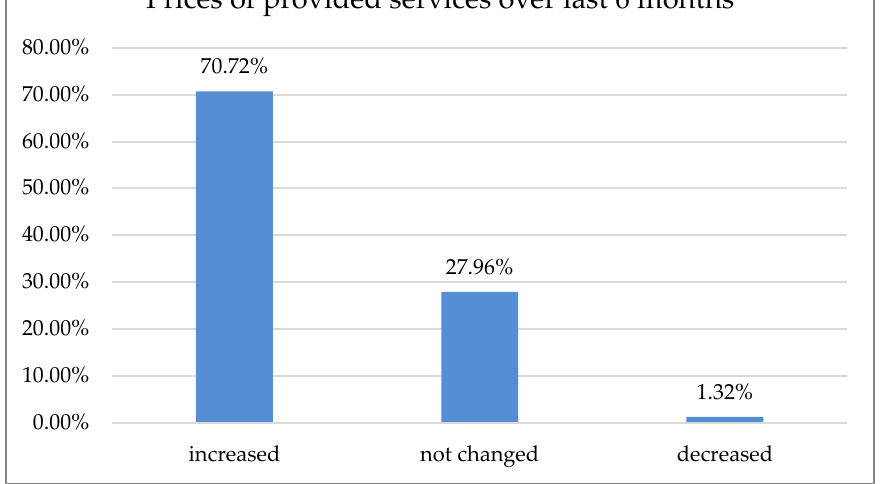
Figure 3. Changes in prices during the last six months.